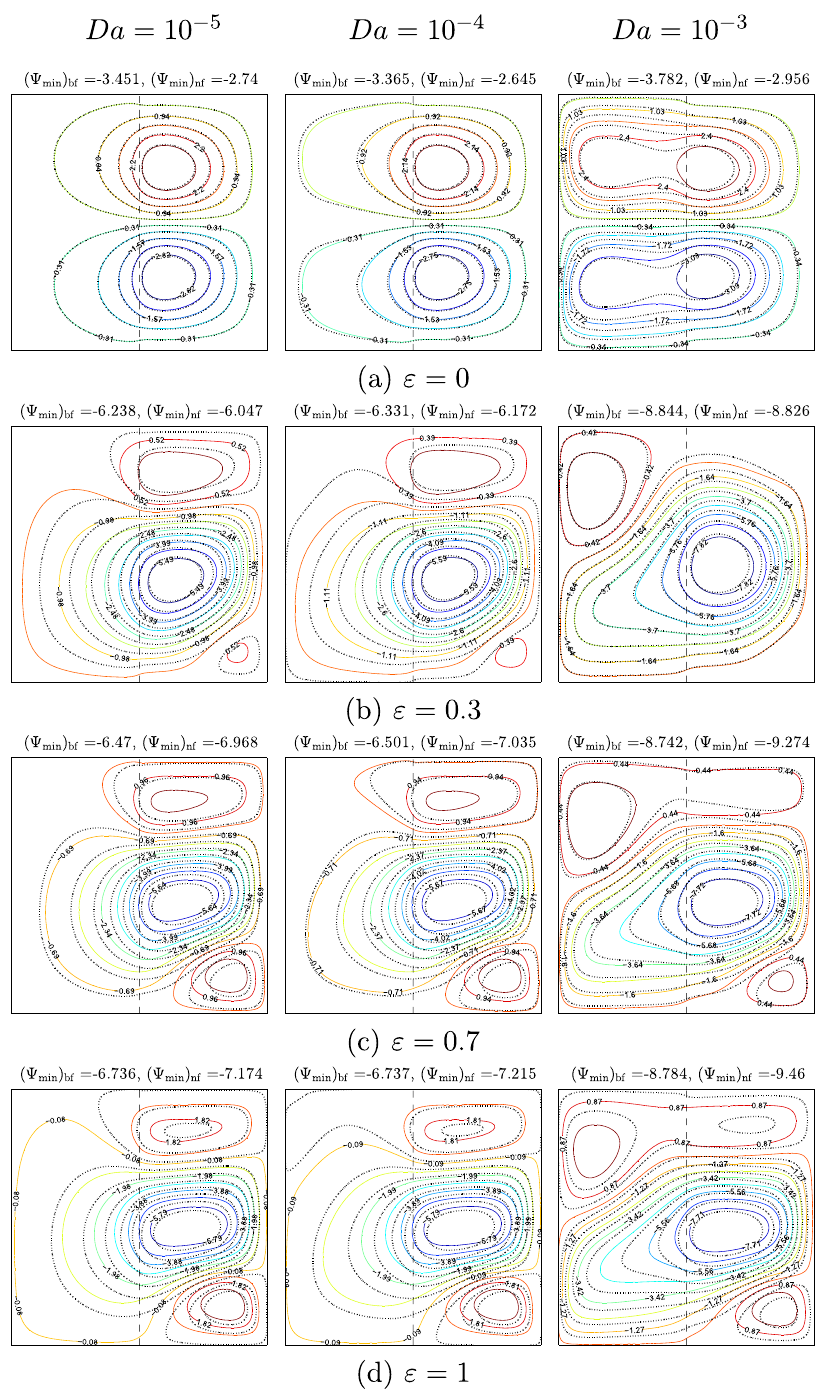
Figure 6. Streamlines evolution by ε and Da for Ra bf = 10 5 , γ = π (dashed